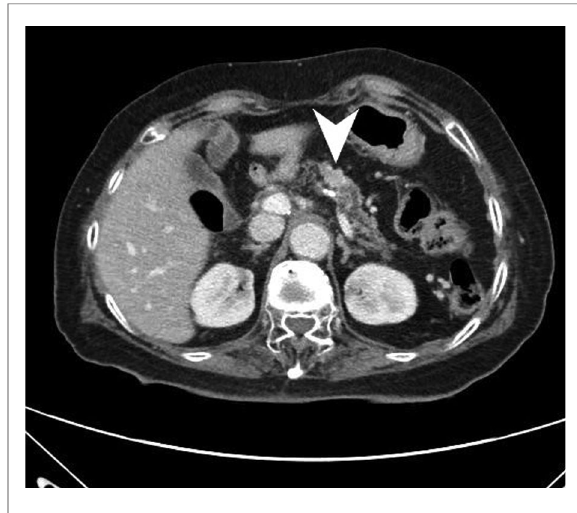
FIGURE 3 Abdominal CT revealed a big lesion (arrowhead) at the remnant pancreas body.